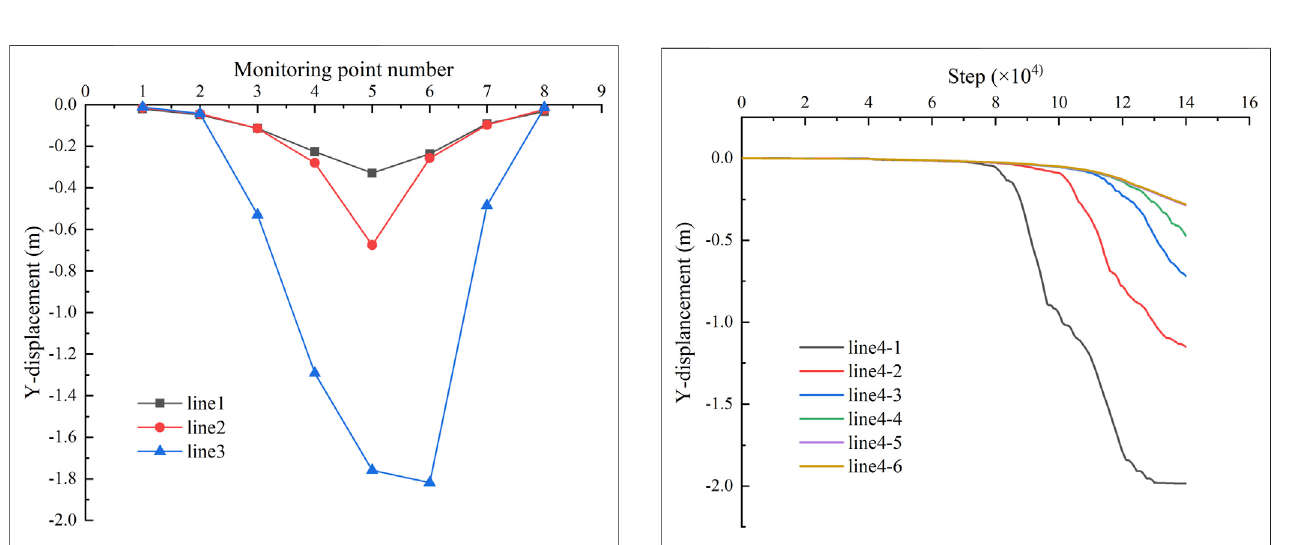
FIGURE 9 | Y-displacement of horizontal lines. FIGURE 10 | Y-displacement of line